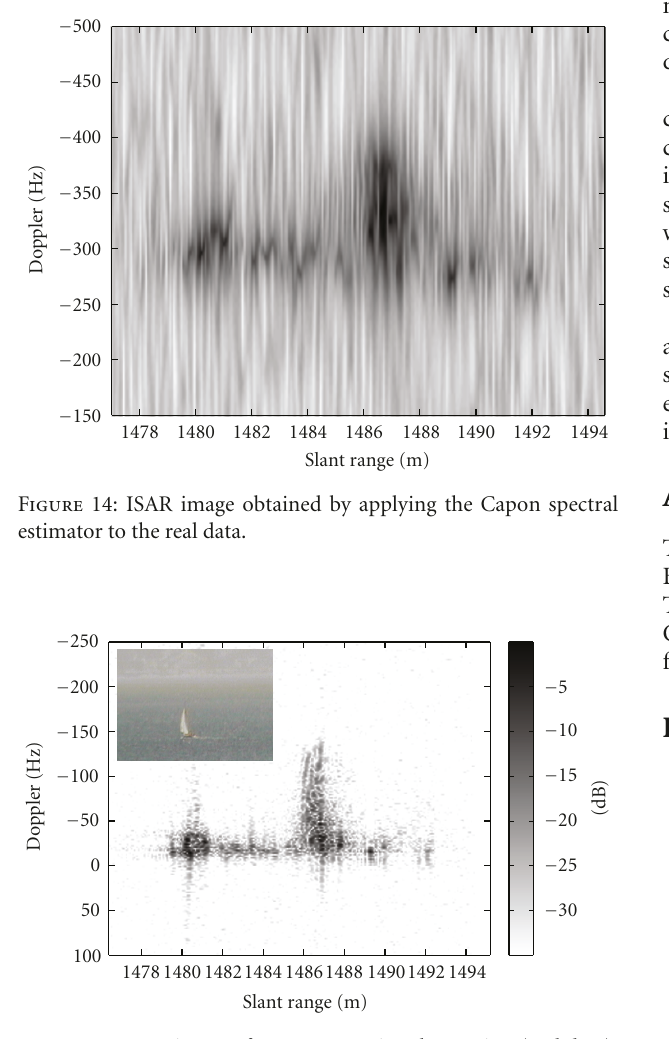
Figure 15: ISAR image after compensating the motion (real data). A photo of the sailboat is given for